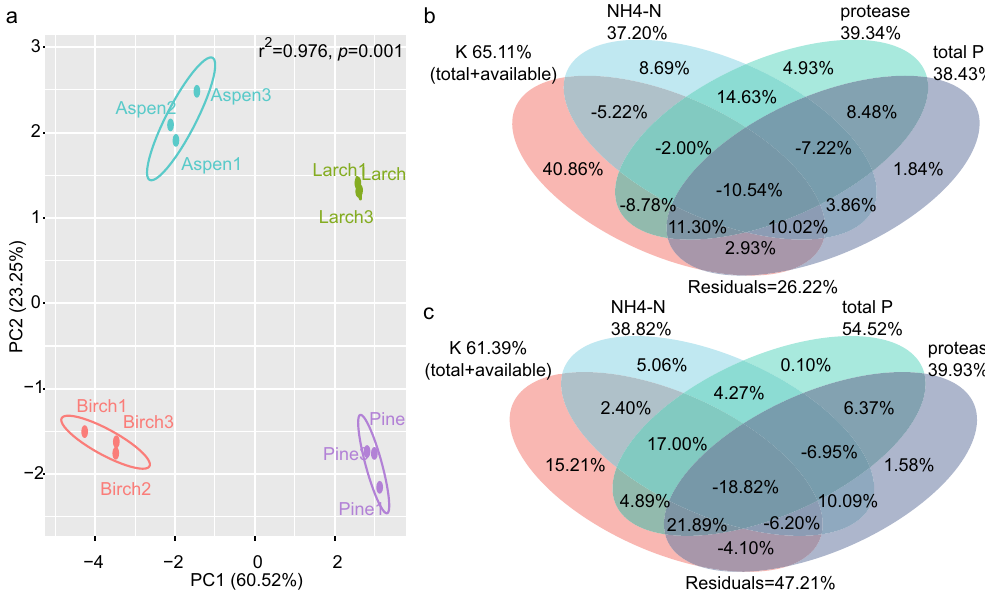
Figure 3. Soil properties. Facet a visualized the PCA results. Fiducial limit for confidence ellipses in this PCA visualization was 0.95. The r 2 and p values at the top right corner are PERMANOVA results. Facets b and c were visualizations of variance partitioning analysis (VPA). Soil properties that highlighted in RDA/CCA analysis were employed to performed VPA with soil fungal ( b ) and bacterial ( c ) communities of these four southern boreal forests respectively.